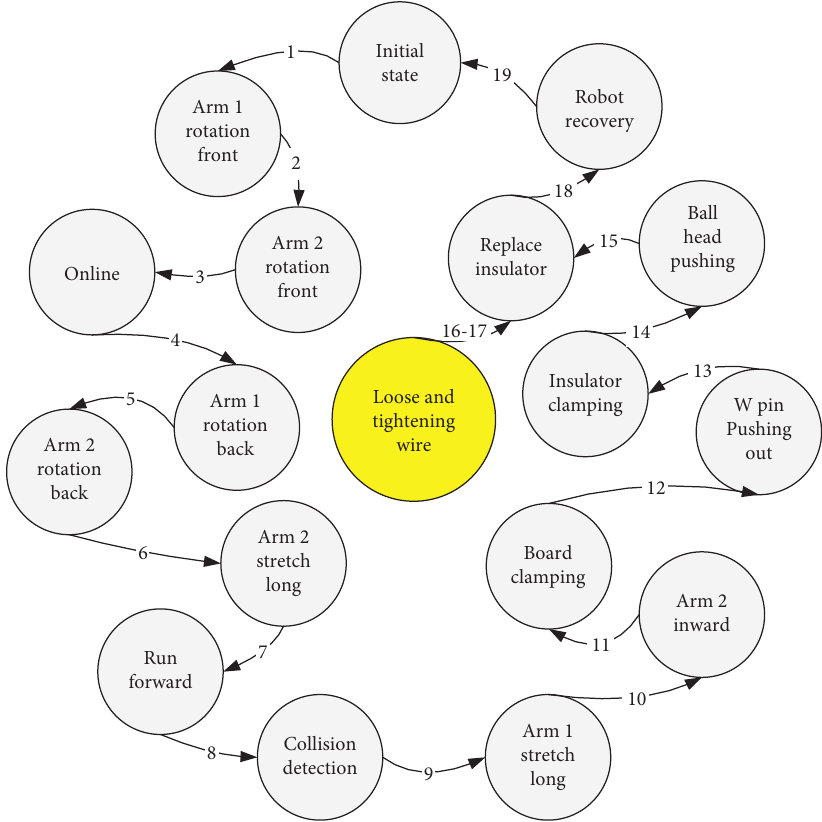
Figure 8: FSM design for insulator replacement